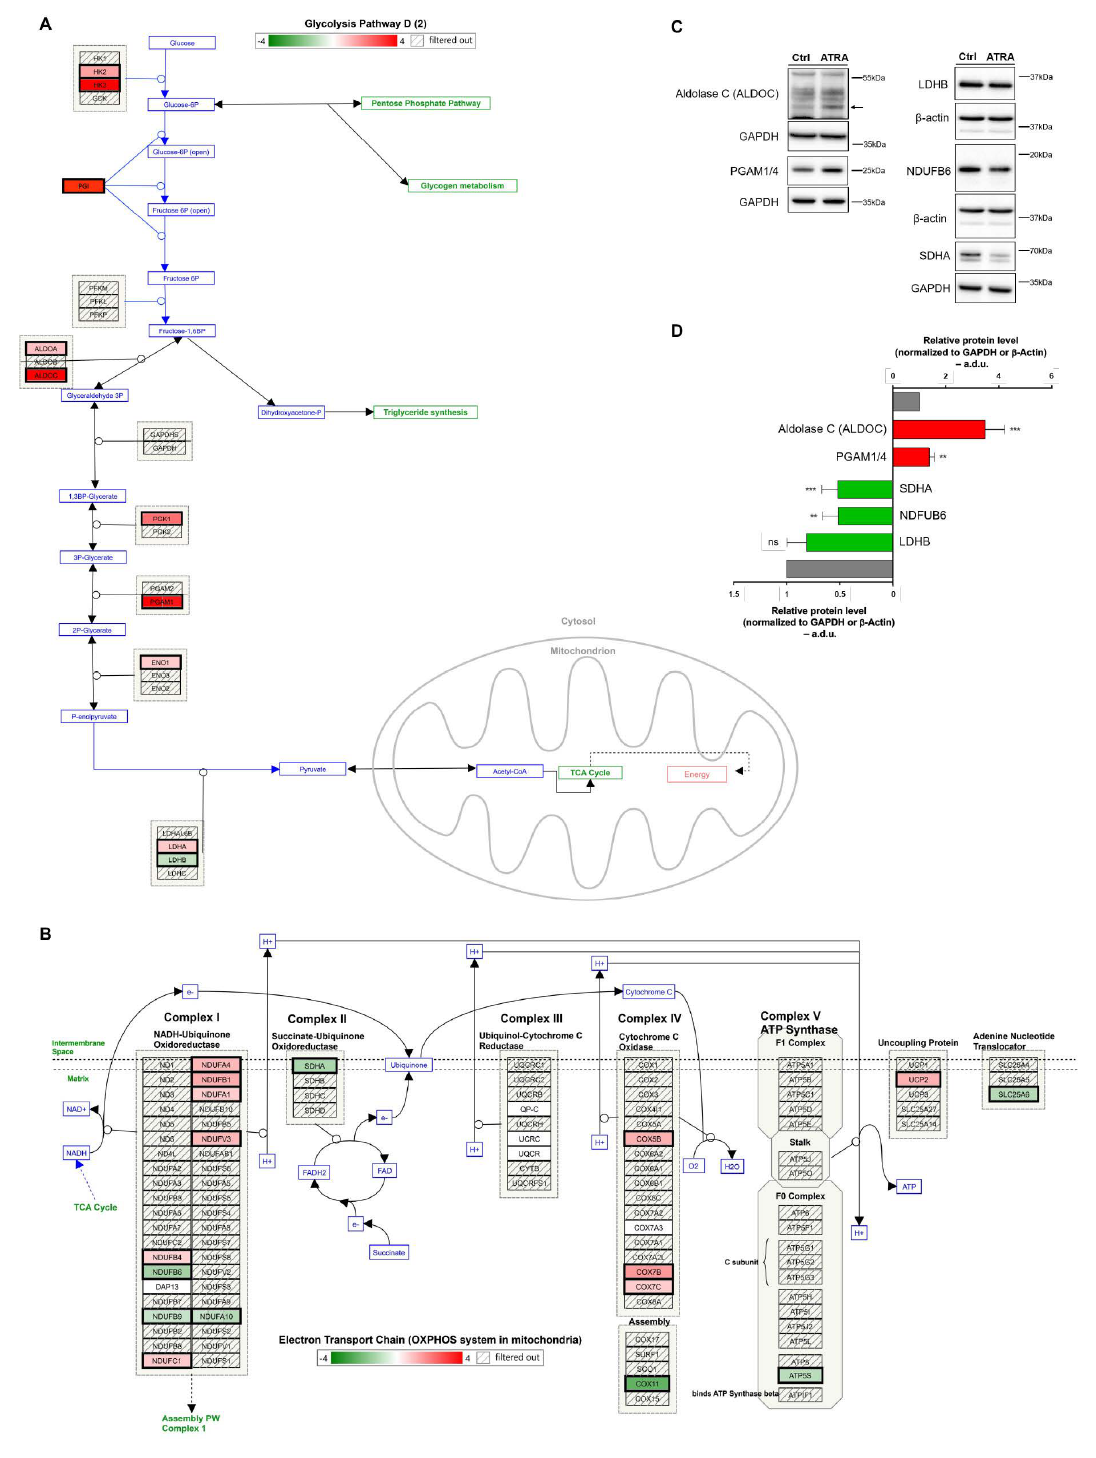
Figure 3. Metabolic variations in the course of NB4 differentiation along the myeloid lineage after treatment with ATRA. ( A ) WikiPathways analysis of the glycolytic pathway enriched in ATRA-regulated genes (FC | 1.5 | ; FDR < 5%). The Transcriptome Analysis Console (TAC) 4.0.2 (Affymetrix, Inc.) allowed to observe that the “metabolic reprogramming pathway” was significantly enriched ( p < 0.001; Fisher’s exact test) in ATRA-regulated genes (nine upregulated genes, and one downregulated gene). Red and green boxes represent up and downregulated genes, respectively. ( B ) WikiPathways analysis of OXPHOS system enriched in ATRA-regulated genes (FC | 1.5 | ; FDR < 5%). The “metabolic reprogramming pathway” was found significantly enriched ( p < 0.001; Fisher’s exact test) in ATRA regulated genes (10 upregulated gene, and 7 downregulated genes). Red and green boxes represent up and downregulated genes,